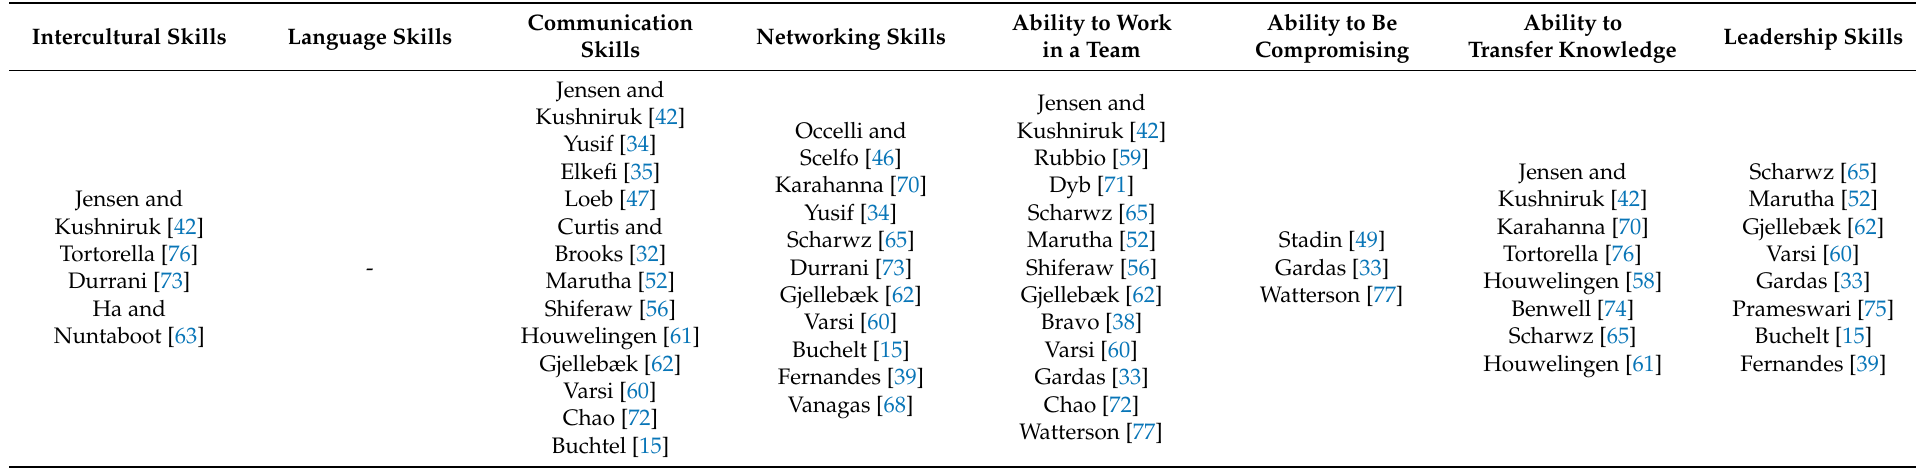
Table 9. Social competencies for adopting H4.0 ICTs and cited literature.